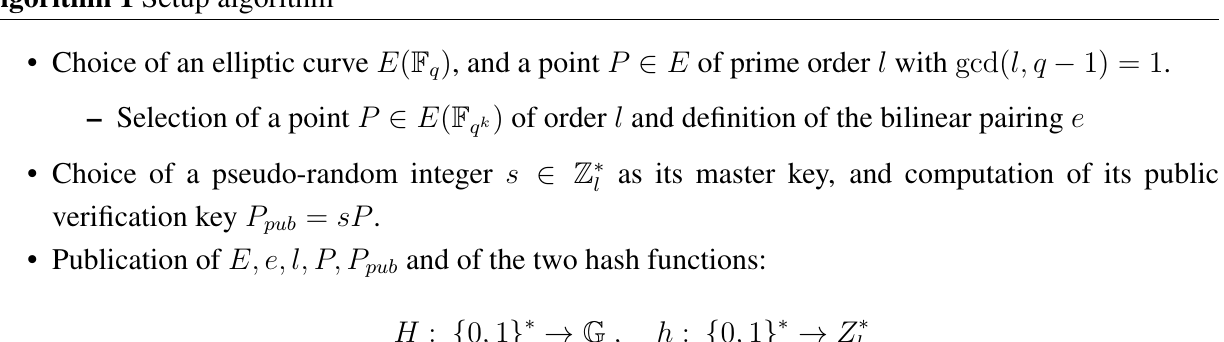
Algorithm 1 Setup